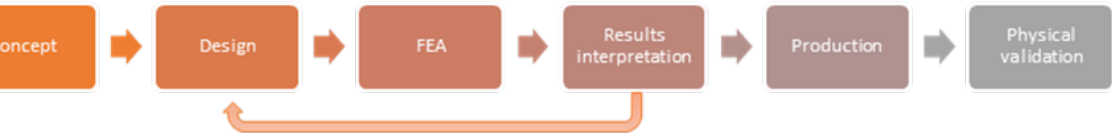
Figure 1. Approached methodology for the WCH design.